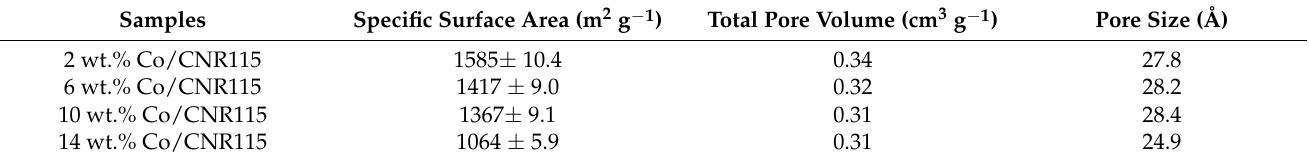
Table 1. Specific surface area, total pore volume and pore size estimated from N 2 physisorption